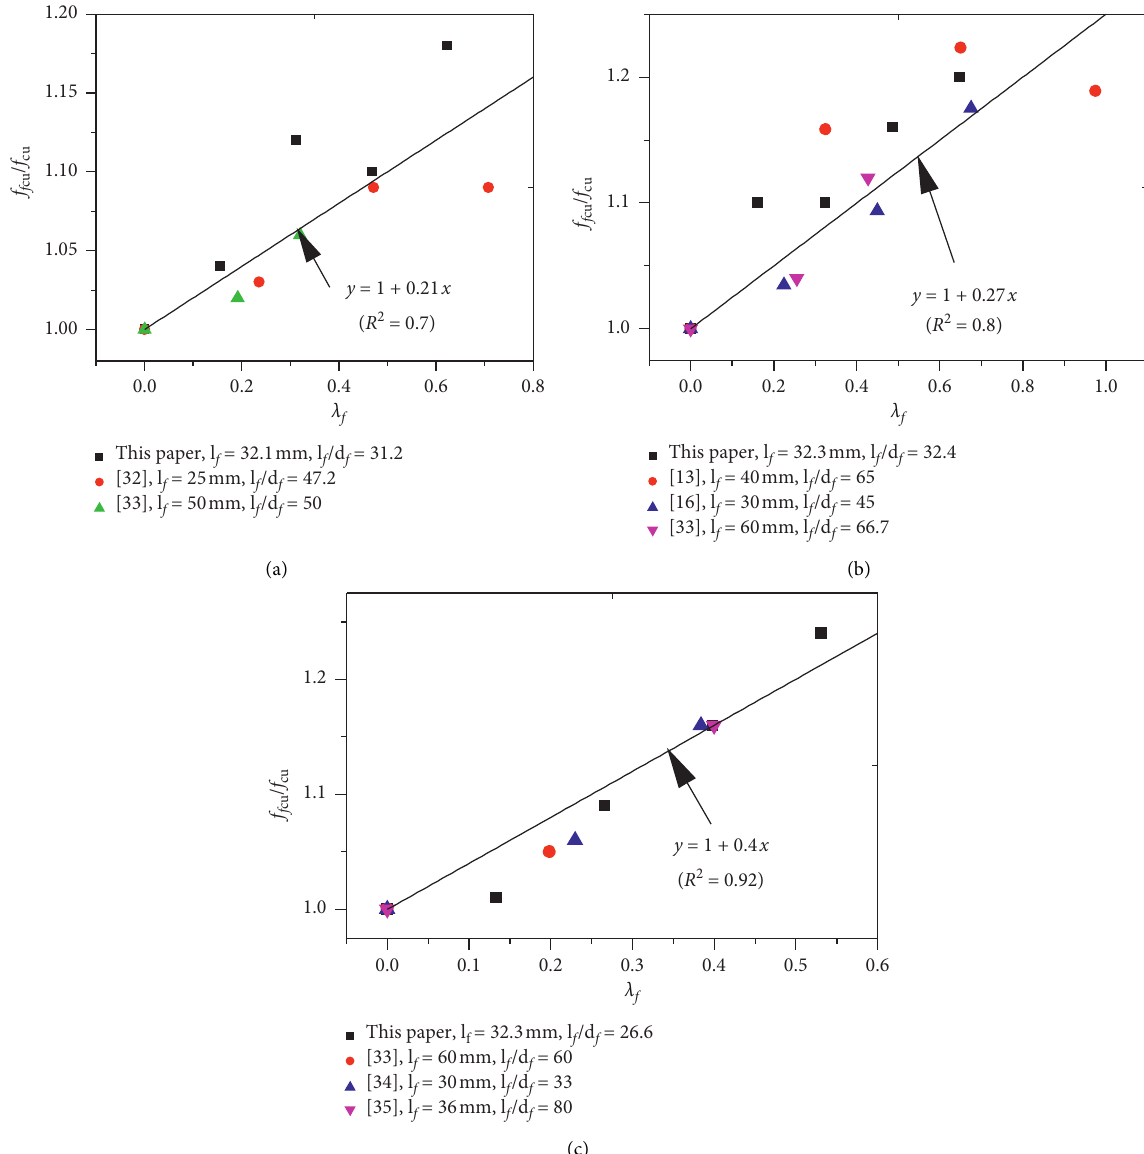
Figure 8: Relationship between f fcu / f cu and λ f (a) ST-F, (b) HE-F, and (c)